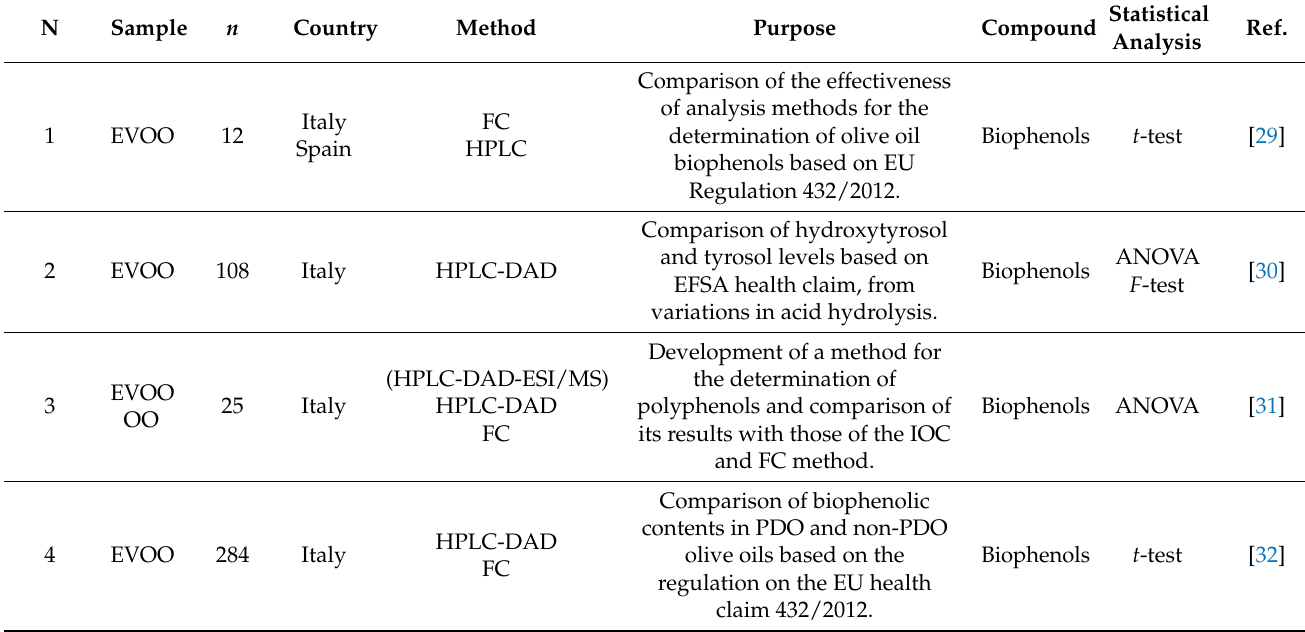
Table 1. References to similar studies on biophenols and health